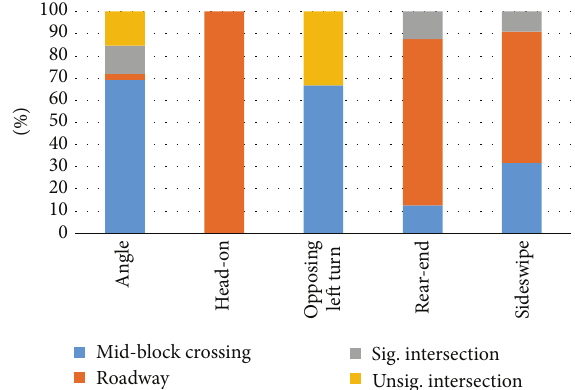
Figure 10: Breakdown of crash locations for various crash